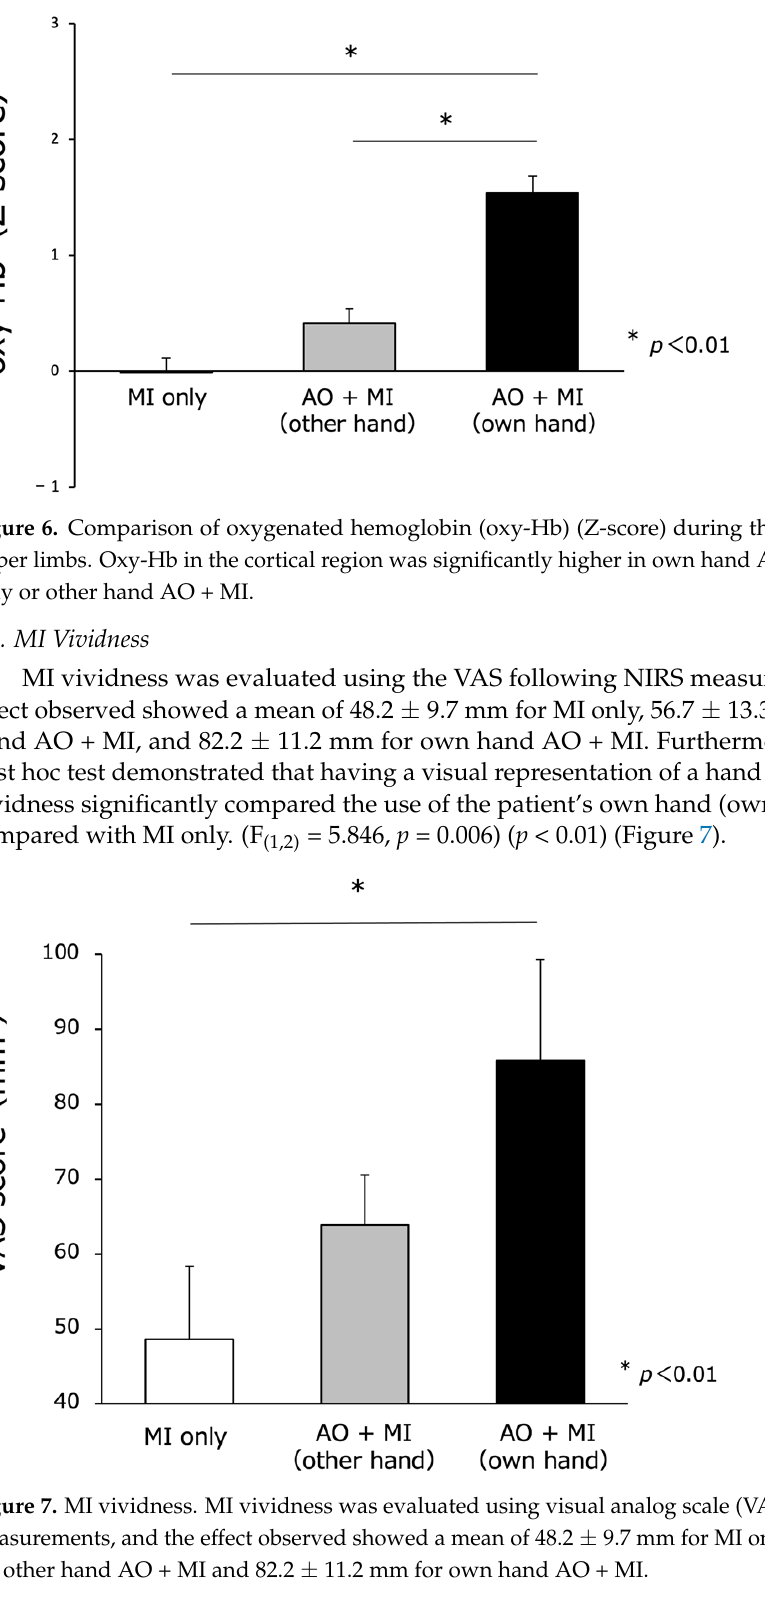
Figure 5. All regions of interest (ROI) during three MI tasks. Cortical activity was observed for all three MI task conditions.